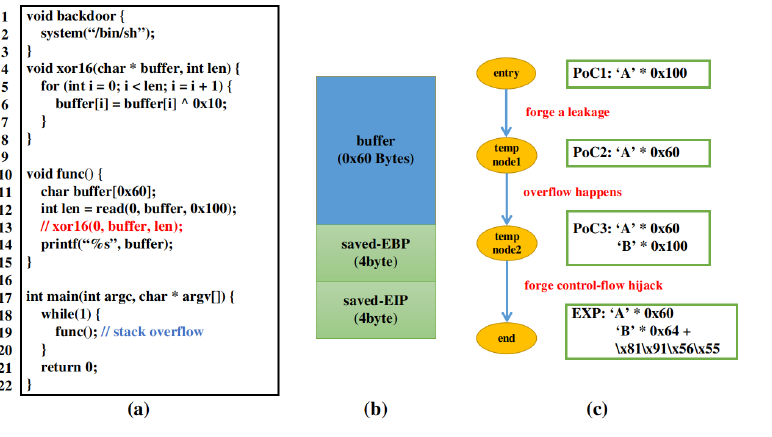
Figure 1. An example of stack overflow exploitation under ASLR environment. ( a ) shows the source code of the example. ( b ) shows the stack frame of func when being called by main. ( c ) shows the exploitation steps carried out with corresponding POC or exploit data shown on the